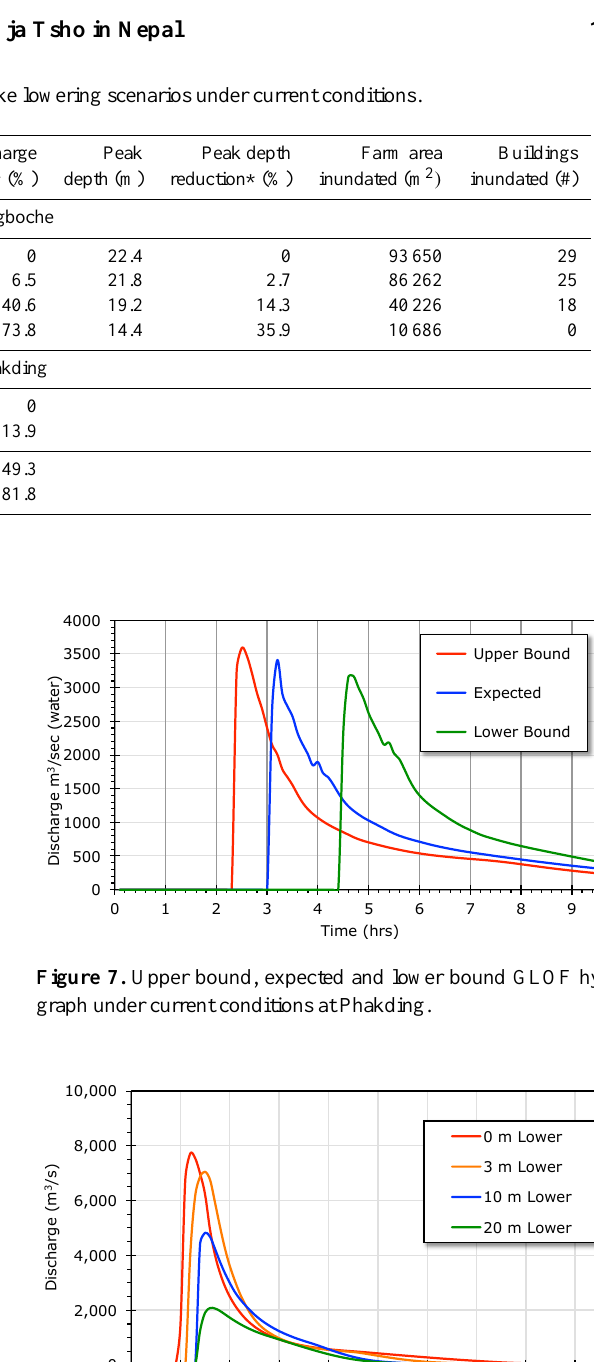
lake by 3, 10 or 20 m, respectively (Table